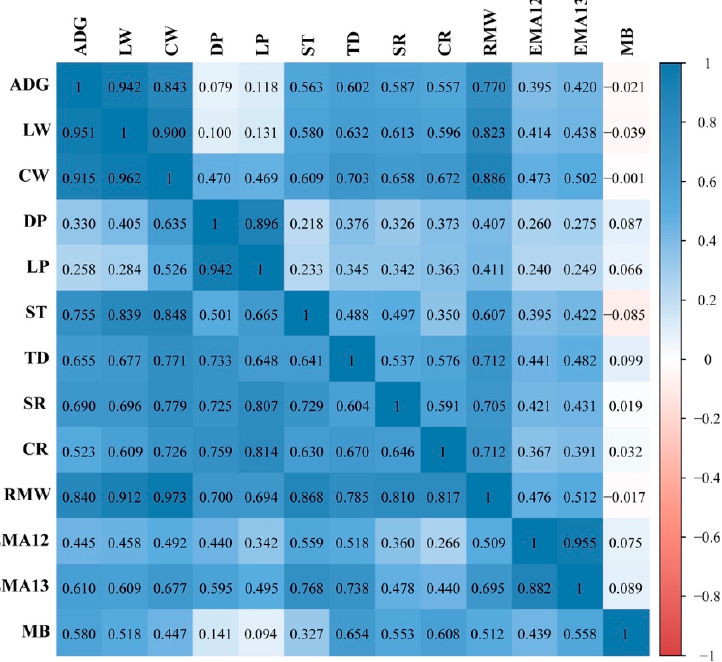
Figure 2. The estimated genetic and phenotype correlations of 13 traits. The upper and lower trian- gle regions of the matrix show the phenotype correlations and genetic correlations, respectively. triangle regions of the matrix show the phenotypic correlations and genetic correlations,